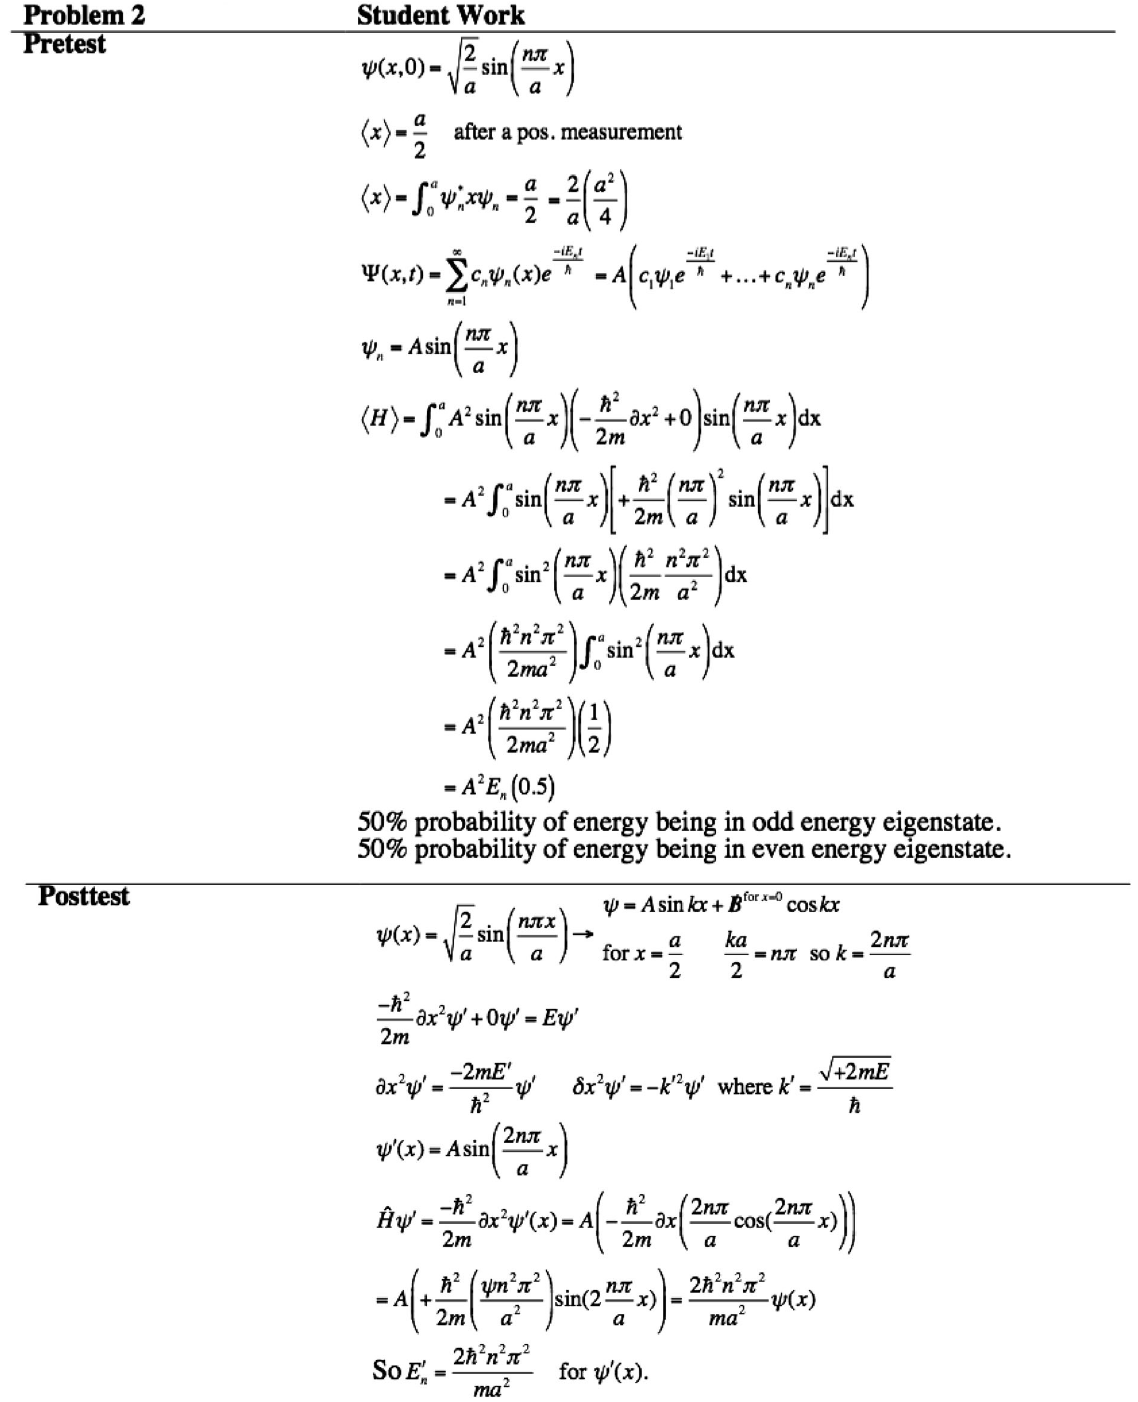
FIG. 4. An example of a pretest and posttest solution pair for a student from the comparison group for the measurement problem. The pretest and posttest scores are 36% and 8% for invoking, 13% and 17% for applying, and 24% and 13% for the overall scores, respectively. The student struggles with this problem in the pretest. In the posttest, no improvement is